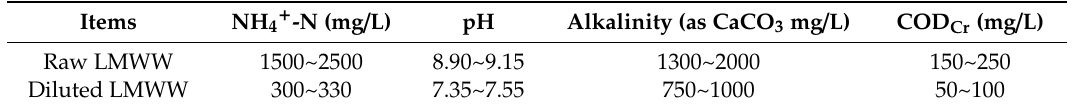
Table 1. The characteristics of liquid-ammonia mercerizing